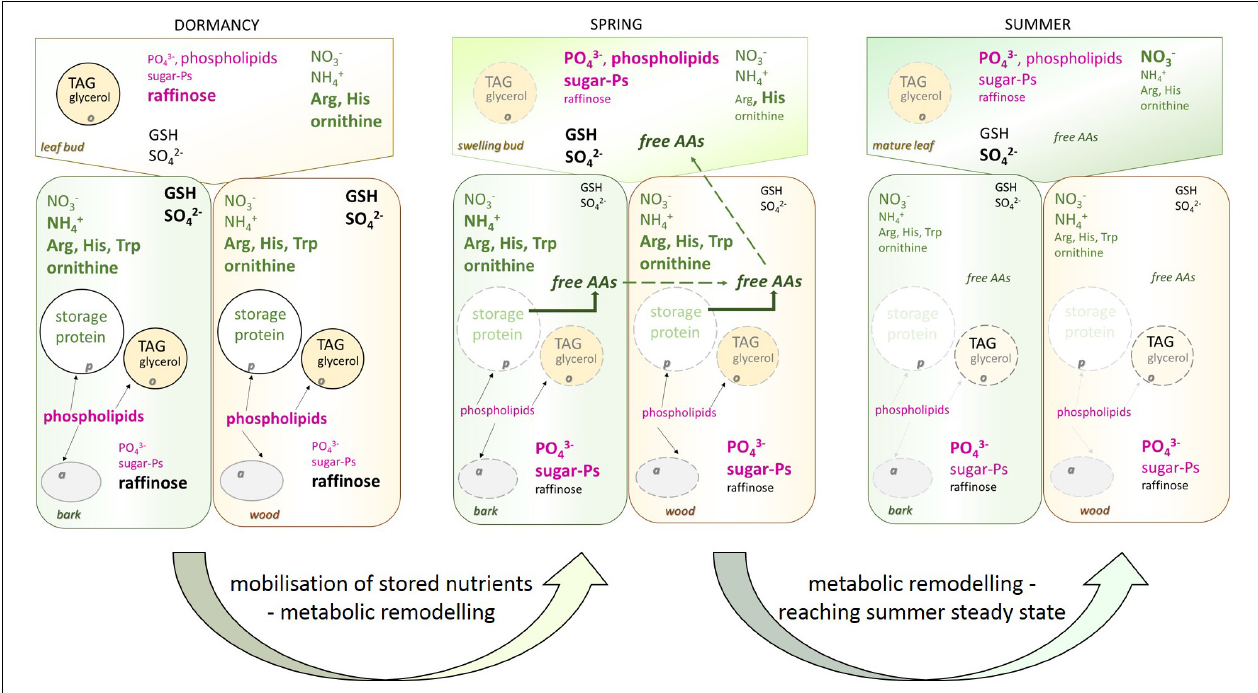
FIGURE 9 | Overview of seasonal changes in metabolite and lipid abundances in poplar twigs. Seasonal differences in metabolite and lipid abundances in the twig buds/leaves, bark, and wood is summarized for dormancy, spring and summer. Bold and bigger font demonstrated higher abundance of the compound in relation to other season(s). Vice versa smaller letter indicate lower amount of the compound in relation to other season(s). Magenta written compounds relate to the P metabolism, green written compounds relate to the N nutrition while black or gray written compounds refer to the C and S metabolism. Light gray and light green fonts indicated the low abundance of TAG, glycerol, and of protein at this time of the year. Black arrows show the places of phospholipids. Broken lines of protein body, amyloplasts and oleosome in spring indicated their degradation. a, amyloplast; o, oleosome; p, proteine body; AAs, proteinogenic amino